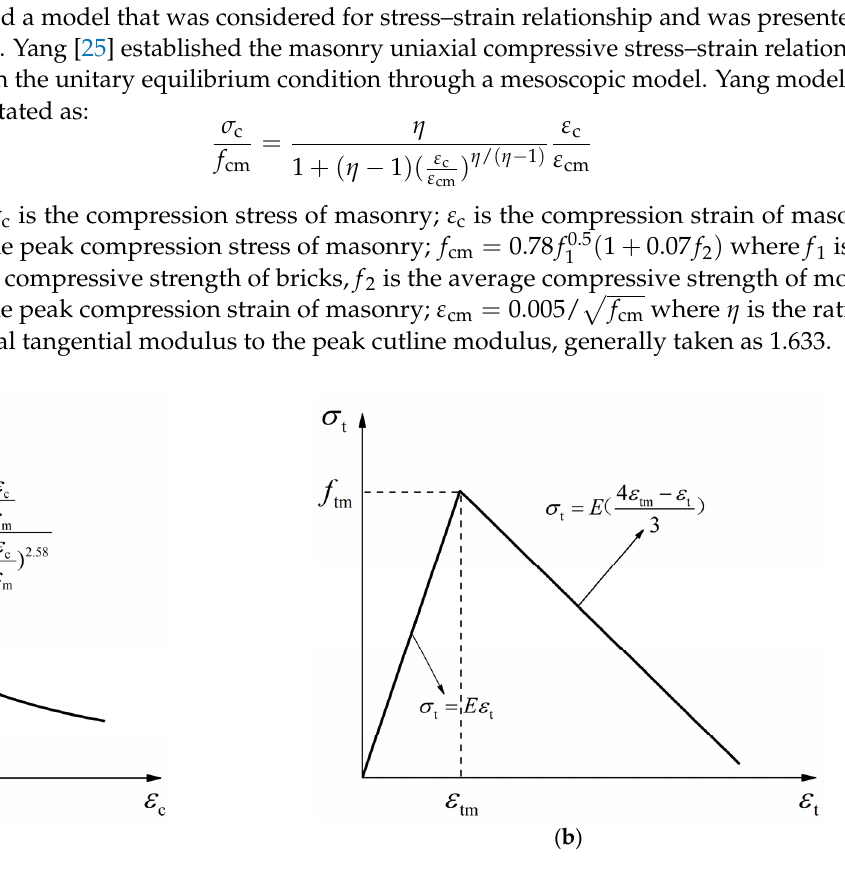
Figure 4. Stress–strain relationships used for masonry: ( a ) Compressive behavior based on Yang model [25]; ( b ) Tensile behavior based on Sekender Ali model [26].